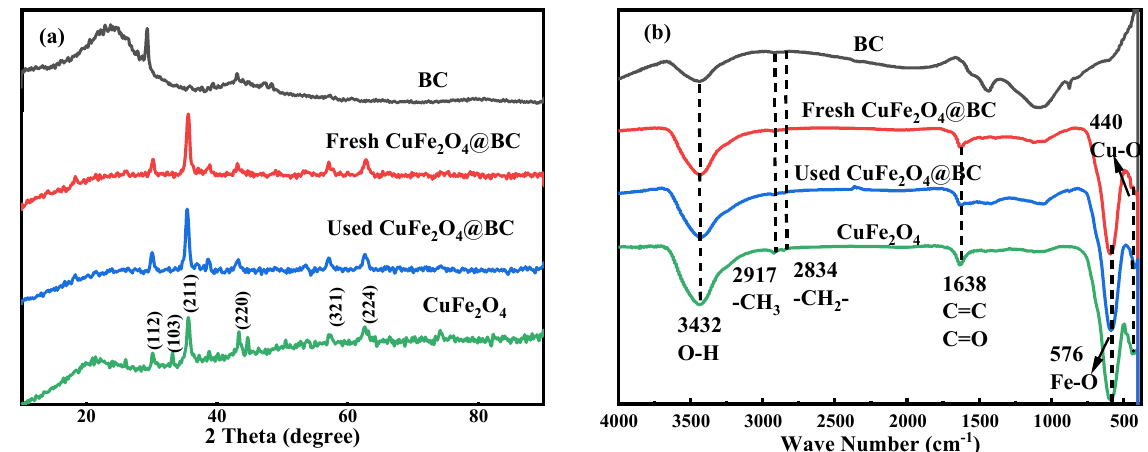
Figure 2. ( a ) XRD patterns and ( b ) FT–IR spectra of the prepared catalysts.